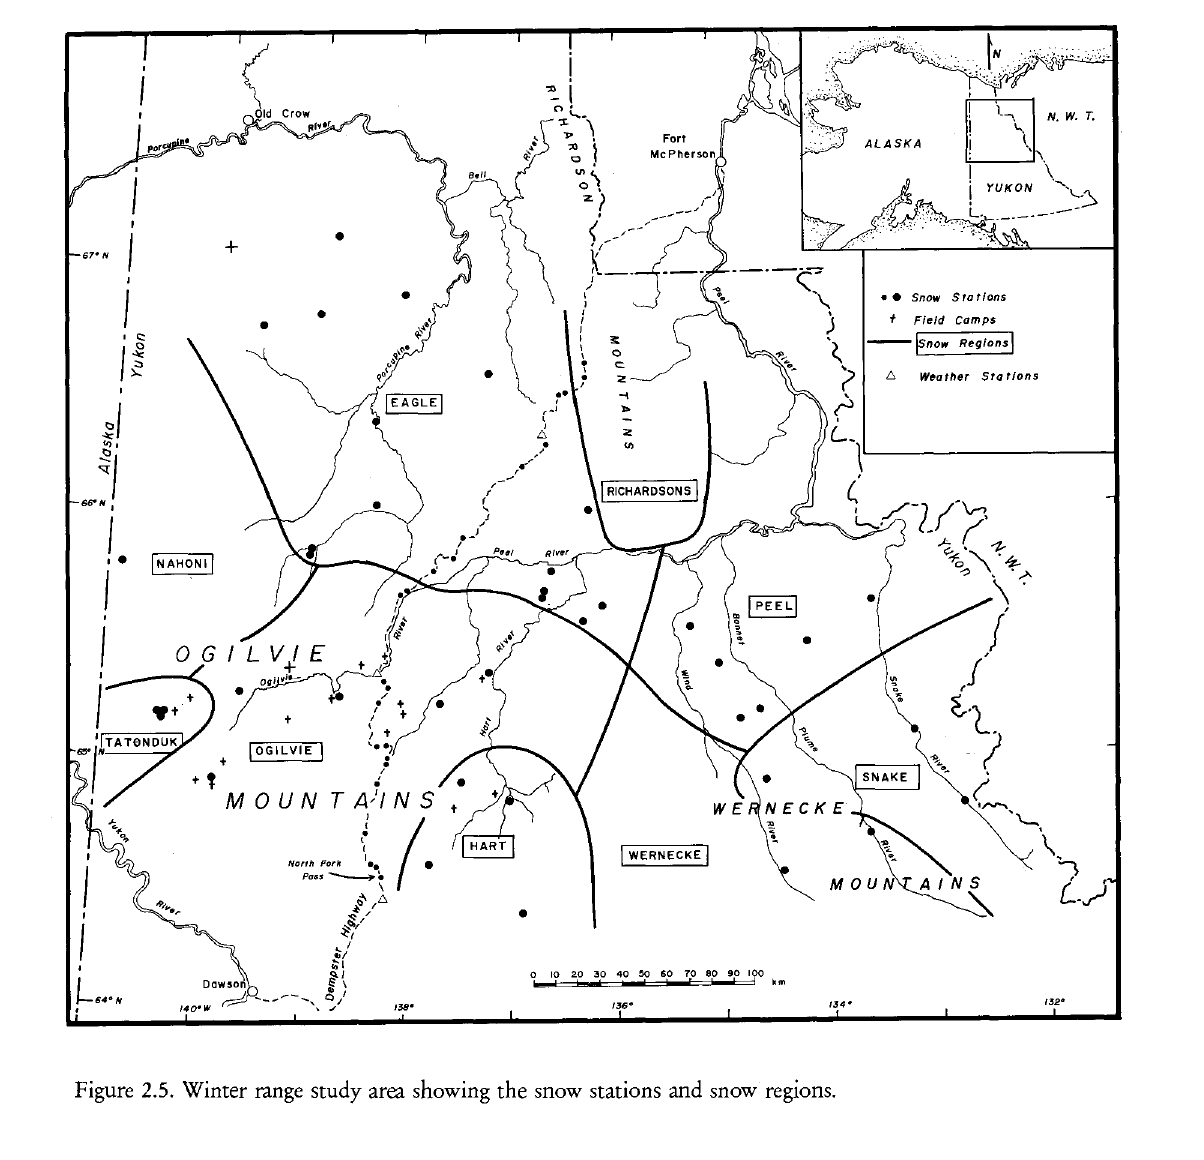
Figure 2.5. Winter range study area showing the snow stations and snow